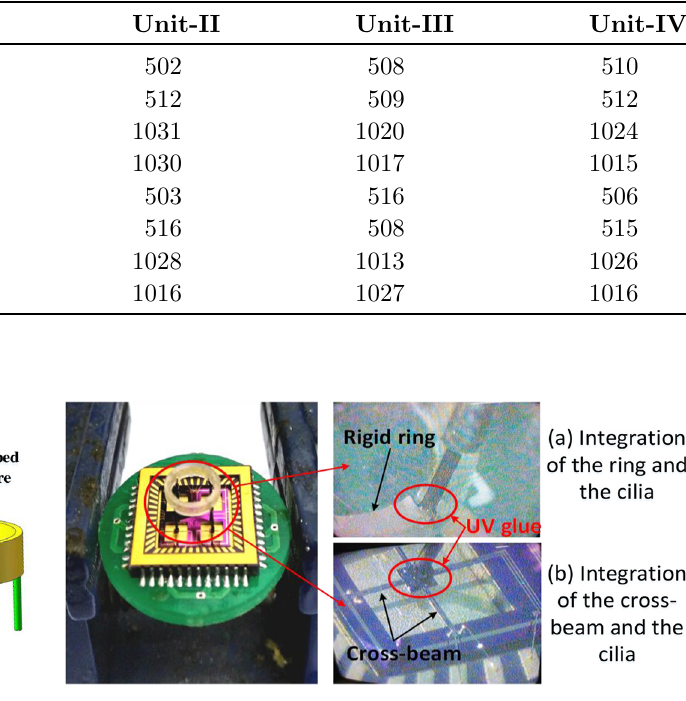
Fig. 16. Integration progress